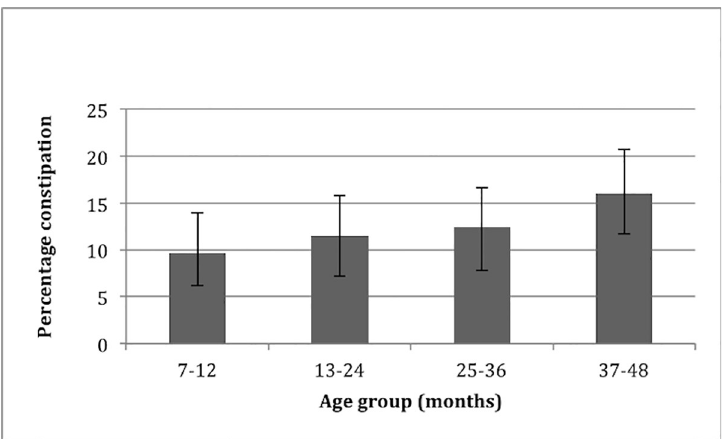
Fig 1. Prevalence of functional constipation per age group. Error bars depict 95% confidence interval.